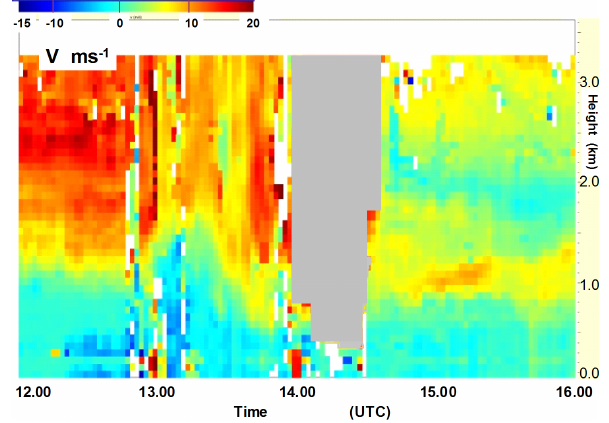
Fig. 8b. Wind V component measured by the wind profiler at Linkenholt 24 June 2005, 12:00 to 16:00UTC from 75 to 3250m a.g.l., doubtful measurements are greyed out.